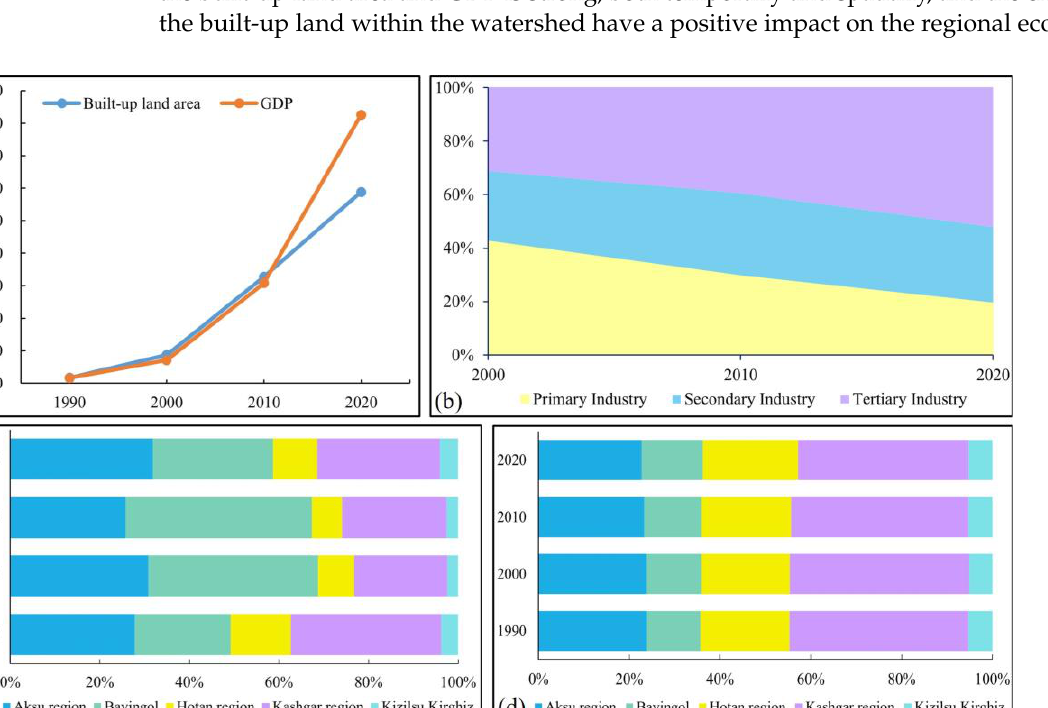
Table 2. Land use dynamic attitude in the Tarim River Basin, 1990 – 2020 (%).